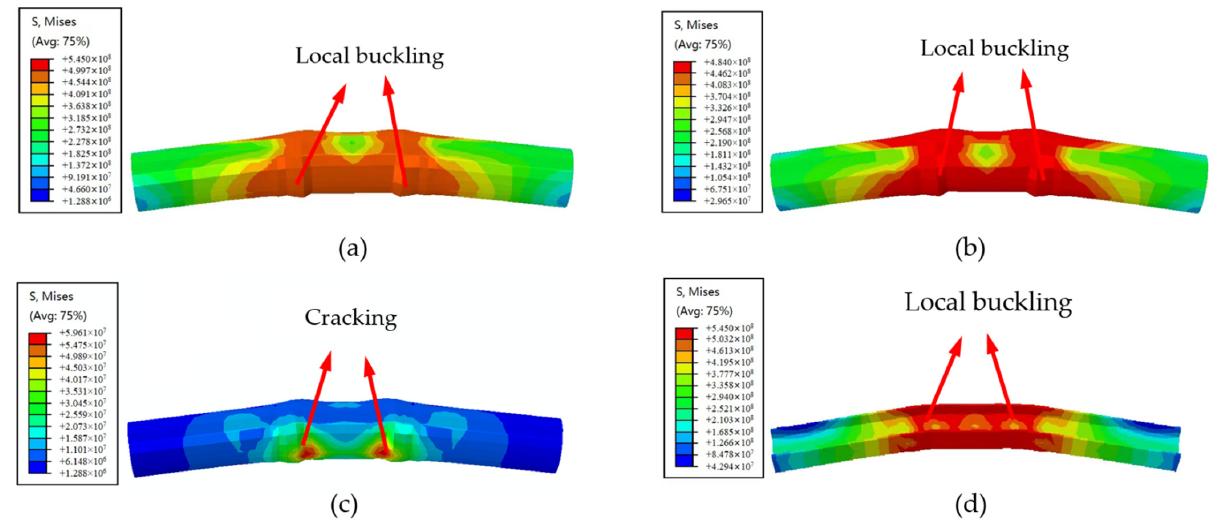
Figure 9. Failure mode of specimen SRCFST: ( a ) SRCFST; ( b ) Tube; ( c ) Concrete; ( d ) Profiled steel.